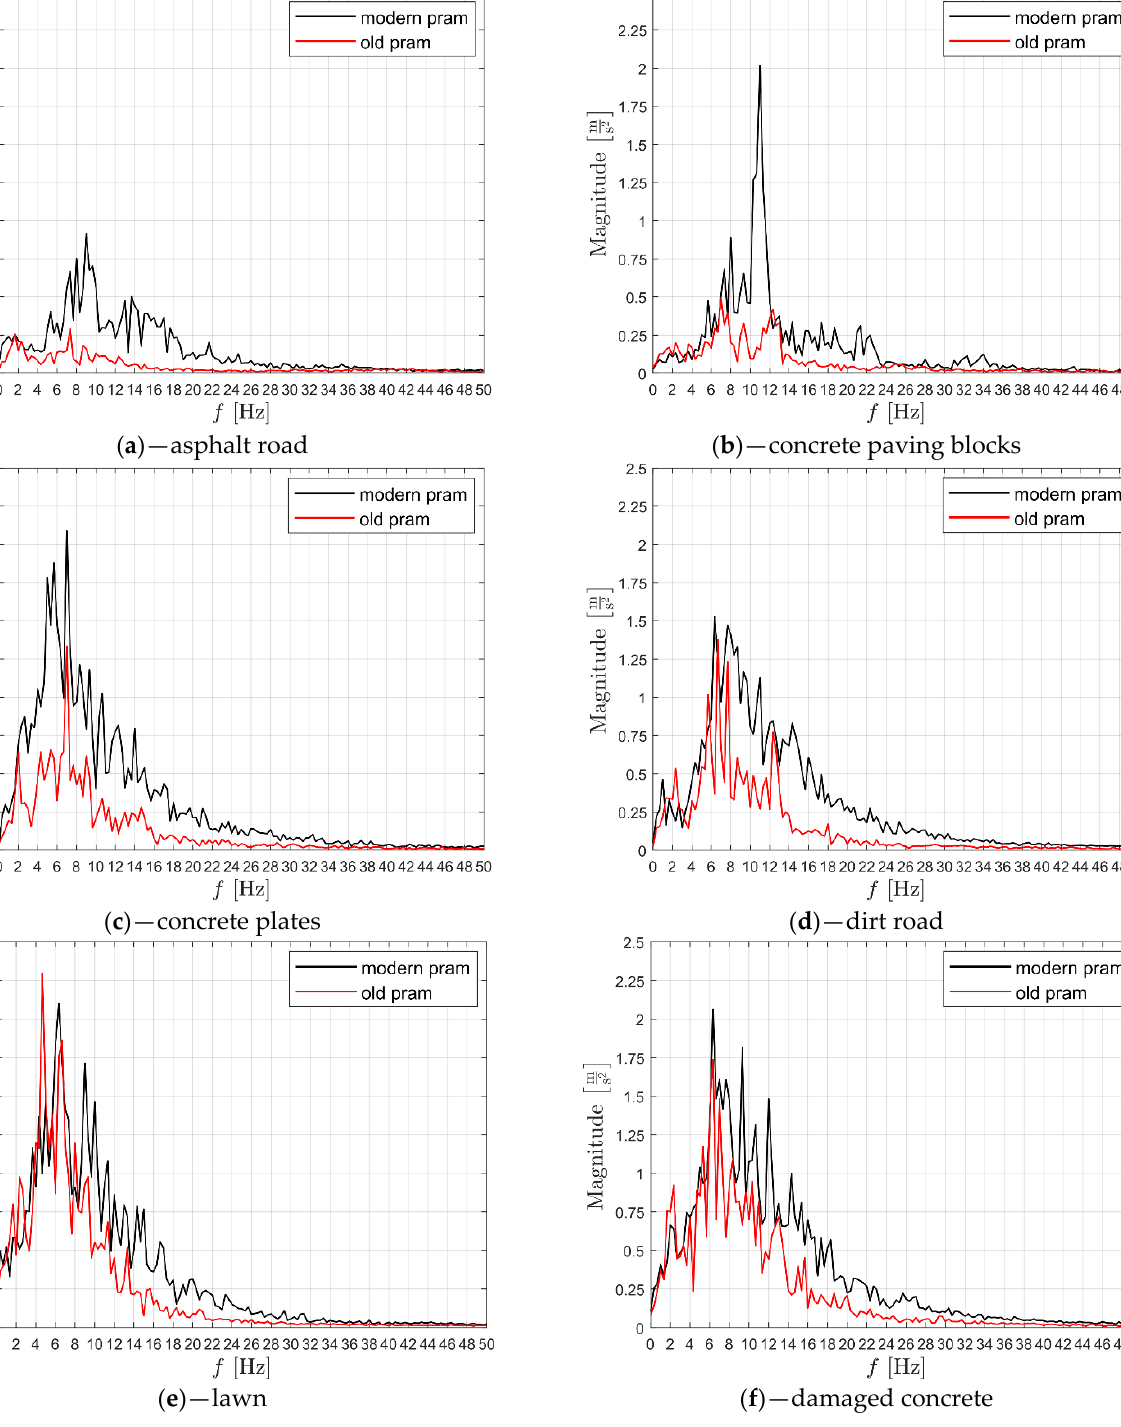
Figure 5. Amplitude-frequency spectra of vibrations of the test object within the frequency range (0, 50 Hz 〉 when stimulated by all six considered types of